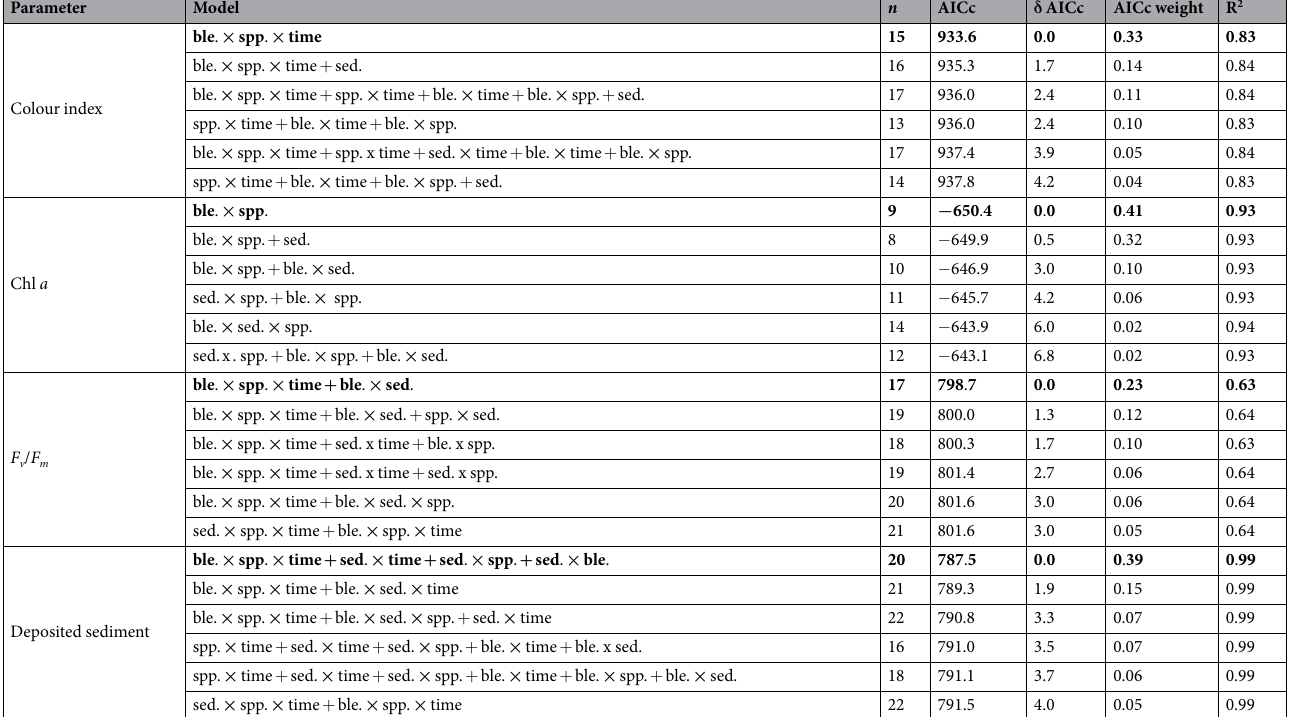
Table 1. Top model fits (generalised linear mixed model) for colour index, Chl a concentrations, maximum quantum yield ( F v / F m ) and deposited sediment for each of the fixed factors, inducing bleaching status (ble.), species (spp.), time and sediment deposition treatment (sed). Shown are the fitted model, number of parameters ( n ), Akaike information criterion (AICc), δ AICc, model weights, and R 2 values. The model with the fewest parameters within 2 AICc is considered the most parsimonious, and therefore the best model. Selected best models are shown in bold